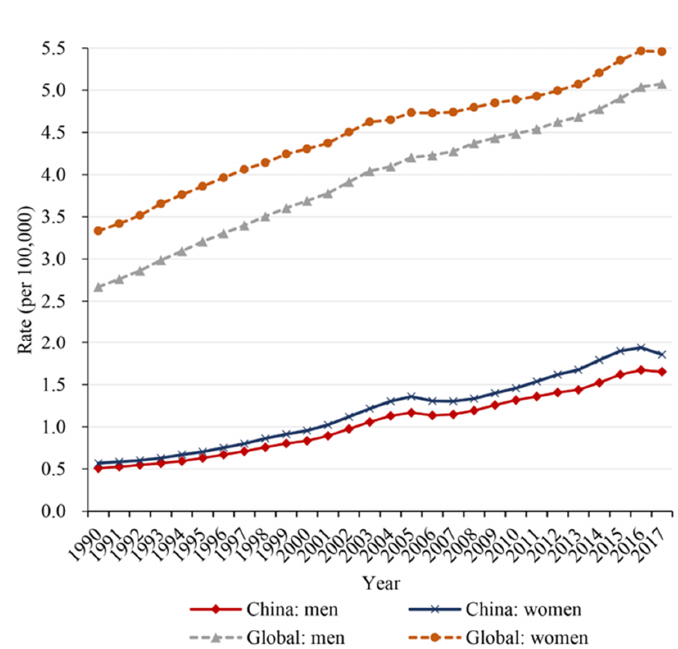
Figure A. The trend in ASMR for diabetes attributable to high body-mass index from 1990 to 2017.